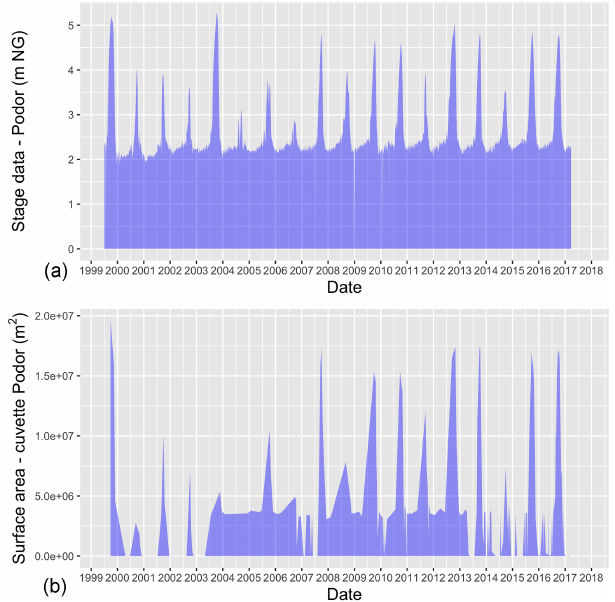
Figure 2. Monitoring surface water variations in the Podor flood- plain using Landsat 5, Landsat 7, Landsat 8 and Sentinel-2A satel- lites (a) compared to daily stage data at Podor (b)